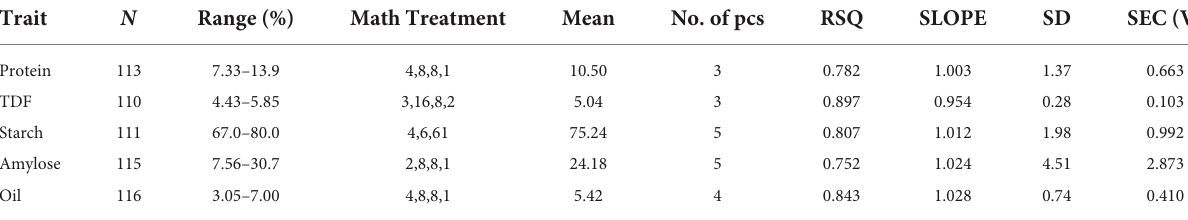
TABLE 2 Calibration of NIRS models with brown rice flour.